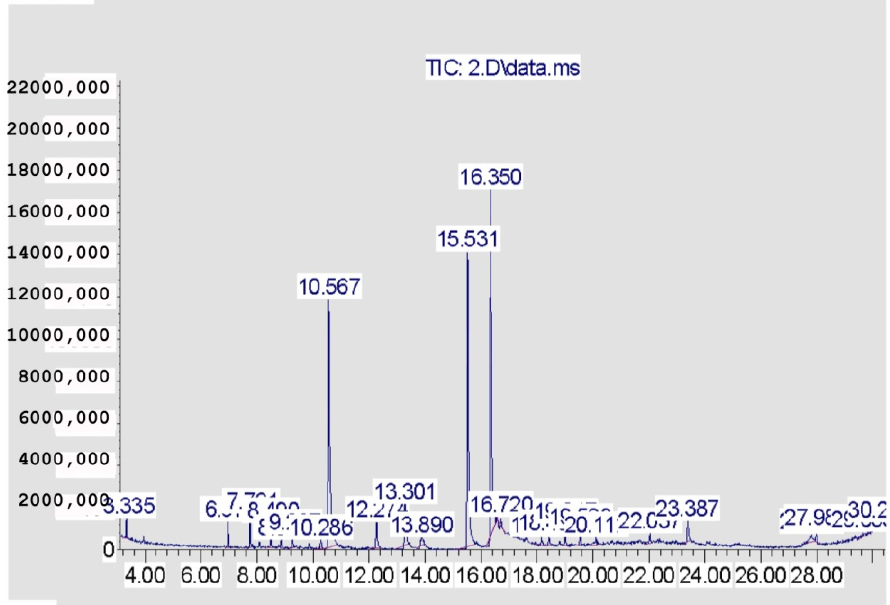
Figure 2. GC chromatogram of C. sinensis (SFME).